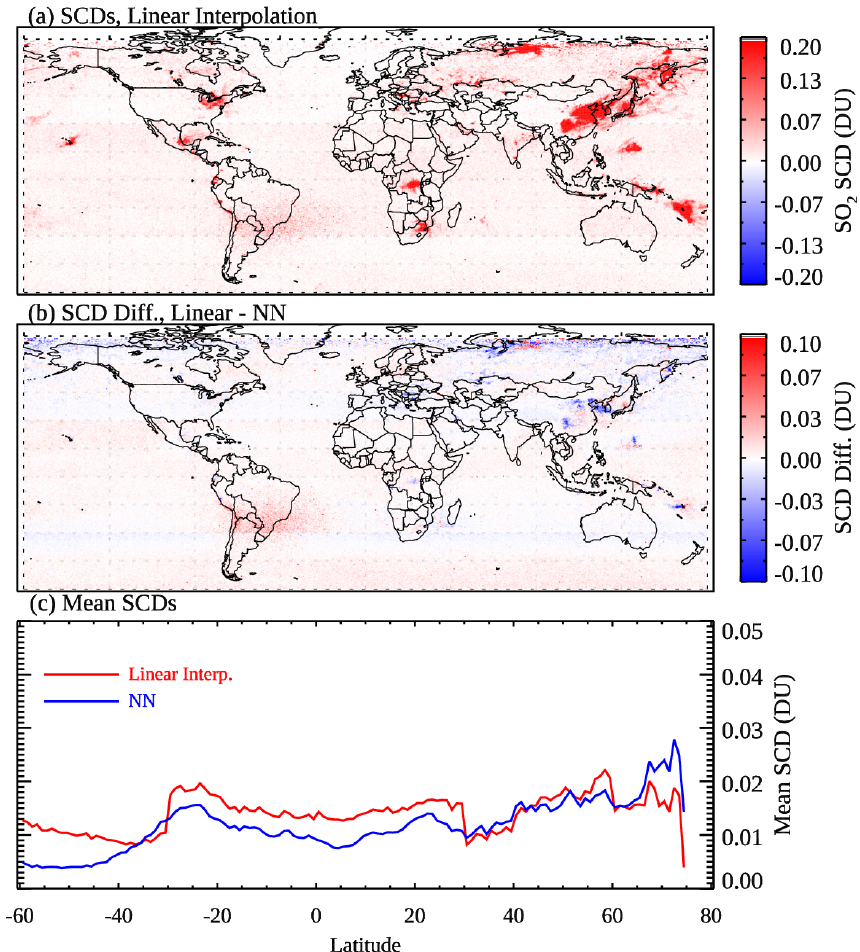
Figure 10. (a) Monthly mean OMI SO 2 SCDs for March 2005, analyzed using a simple linear interpolation model. (b) The differences in the analyzed SCDs between the linear model and the neural networks. (c) Mean SCDs for 1 ◦ latitude bands over generally clean areas (monthly mean SRR < 3), calculated from the SCDs from (red) the linear interpolation model and (blue) the